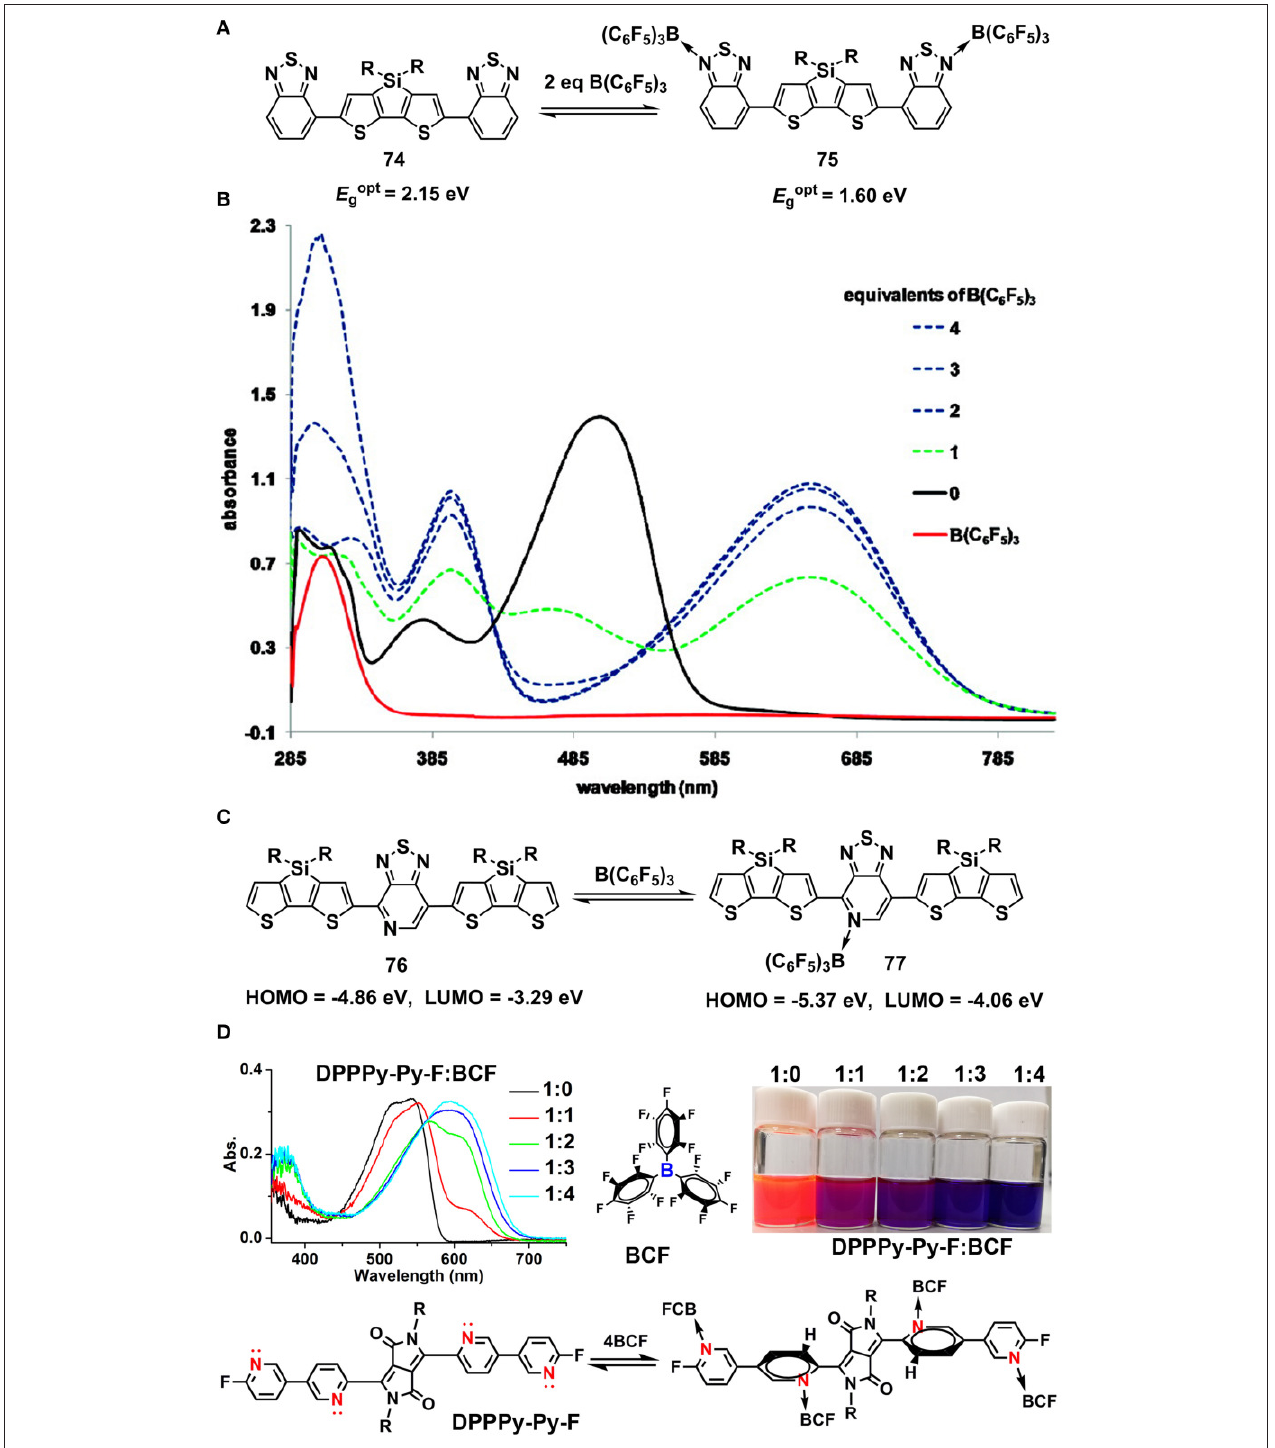
FIGURE 8 | Lewis acid-base coordination (A–C) and the variation of UV-Vis absorption spectra of 74 upon coordinating with BCF (B), Reprinted with permission from Welch et al. (2009). Copyright (2009) American Chemical Society. Manipulation of optical absorption spectra of DPP molecules upon coordinating with BCF (D), Reprinted with permission from Huang et al. (2018). Copyright (2018) Elsevier